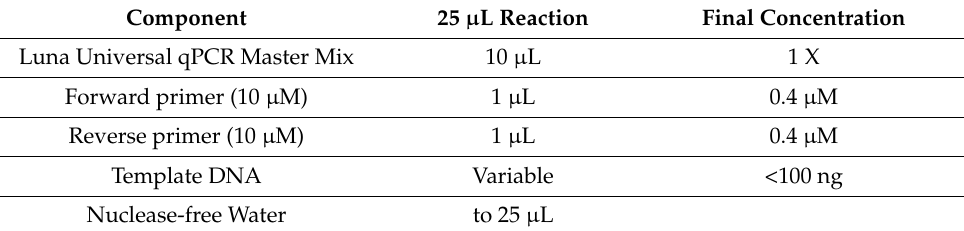
Table 3. Reaction setup for bacteria and viruses with final